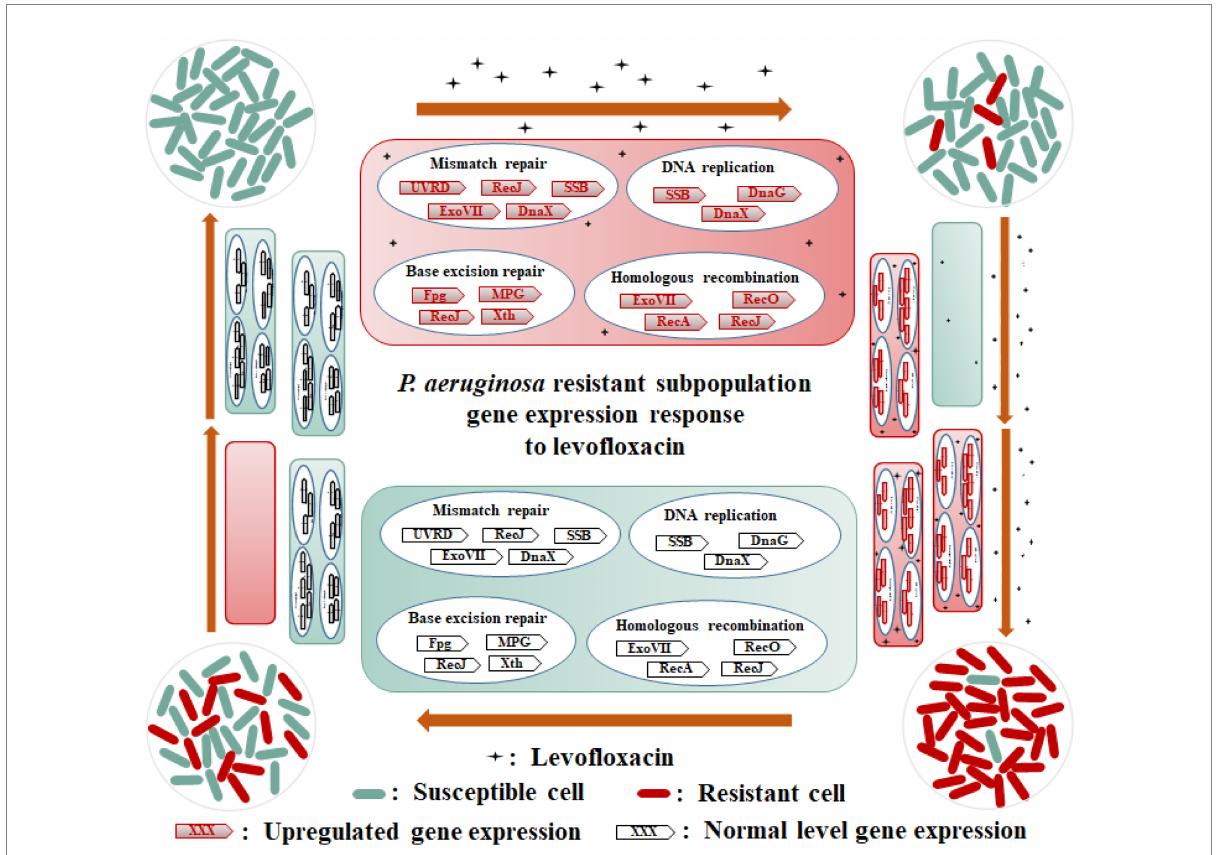
FIGURE 6 Schematic diagram of heteroresistance mechanism of Pseudomonas aeruginosa PAS71 and PAS81 strains to LVX. When exposed to LVX, the expression levels of some essential genes involved in DNA replication (SSB, DnaG, and DnaX), mismatch repair (UVRD, RecJ, SSB, ExoVII, and DnaX), base excision repair (Fpg, Xth, MPG, and RecJ), and homologous recombination (RecA, ExoVII, RecO, and RecJ) pathways of a few subpopulation cells of PAS71 and PAS81 strains susceptible to LVX are elevated; these subpopulations develop into LVX-resistant cells. After continuous exposure to LVX, the resistant subpopulation cells of the PAS71 and PAS81 strains selectively proliferate to become dominant populations. However, in the absence of antibiotic exposure, the expression levels of the essential genes involved in DNA replication and repair of a few resistant subpopulations revert to the parental strain